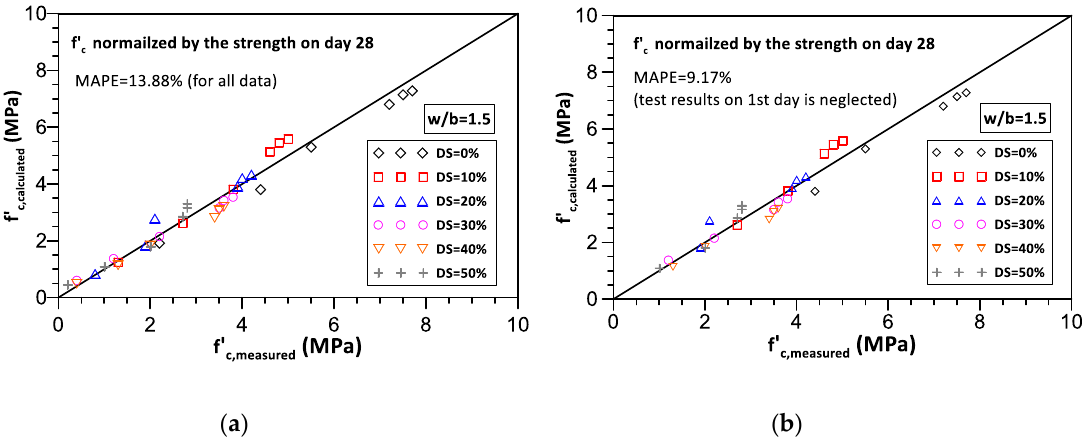
Figure 16. ( a ) Mean absolute percentage error (MAPE) value by applying the compressive strength prediction analysis (considering the results obtained by all curing ages). ( b ) MAPE value by applying the compressive strength prediction analysis (excluding the results obtained from the 1-day sample).